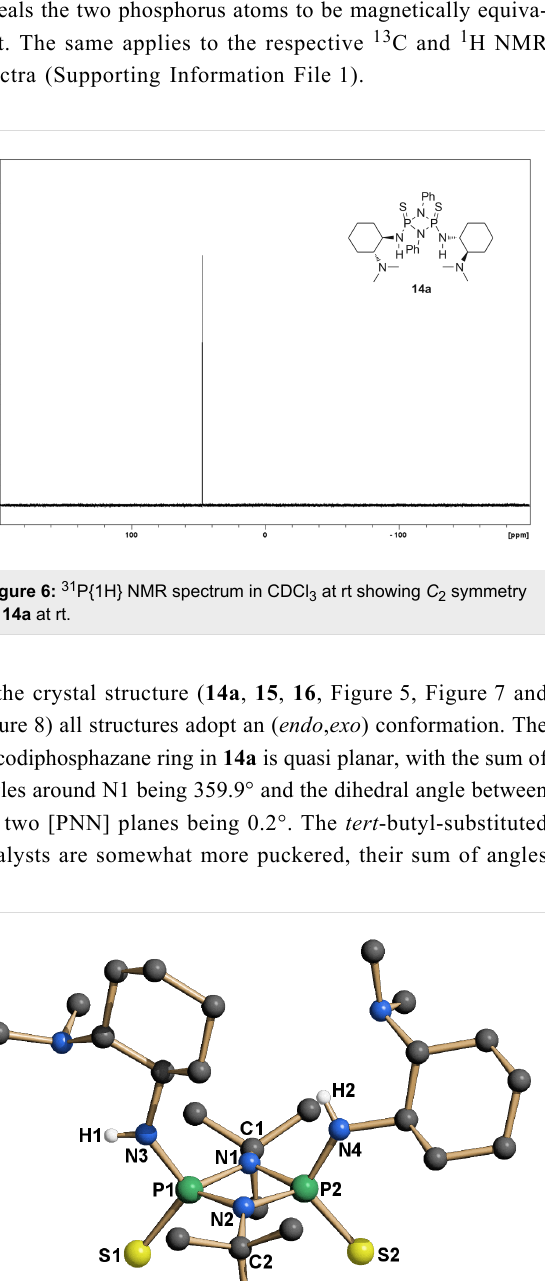
zanes with sulfur (route B , C , Scheme 3). Furthermore the phe- nyl-substituted cis and trans -isomers 14a / 14b need to be stored under inert atmosphere because they decompose slowly when exposed to moisture, while the aliphatic cyclodiphosphazanes 15 / 16 are both completely stable to air. Cyclodiphosphazanes 14a / 14b / 15 are C 2 -symmetric on the NMR timescale at rt ( 14a , Figure 6). This is apparent from the 31 P{H} NMR, which reveals the two phosphorus atoms to be magnetically equiva- lent. The same applies to the respective 13 C and 1 H NMR spectra (Supporting Information File 1).